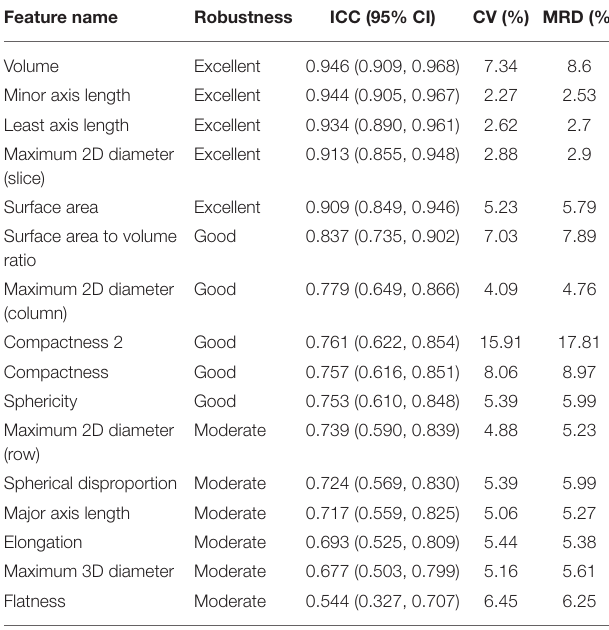
TABLE 4 | Repeatability of left ventricular myocardium shape features in